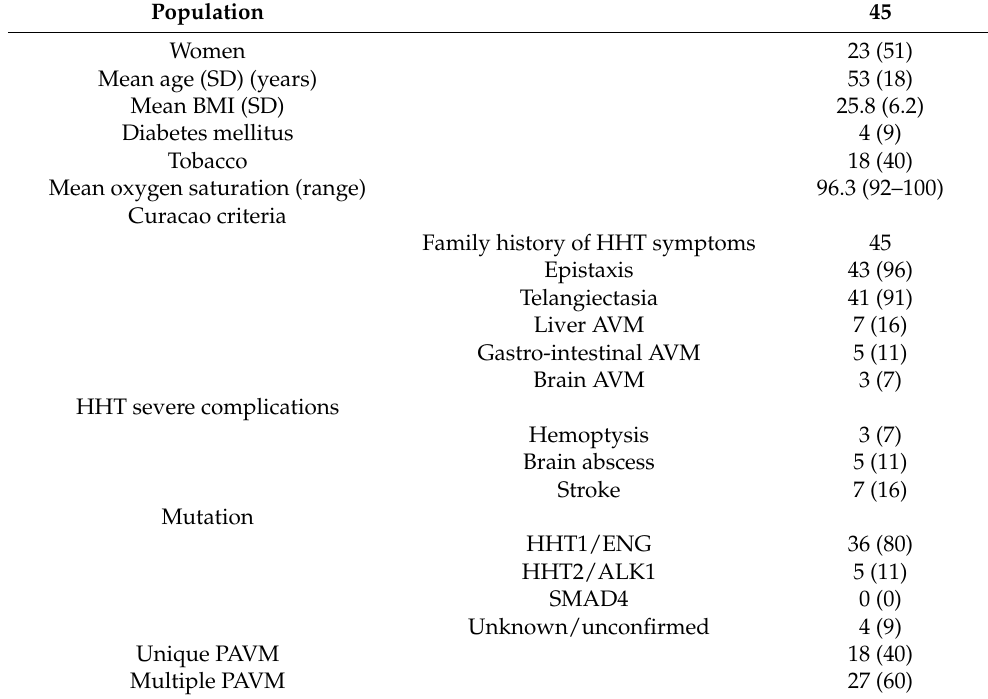
Table 1. Characteristics of patients.